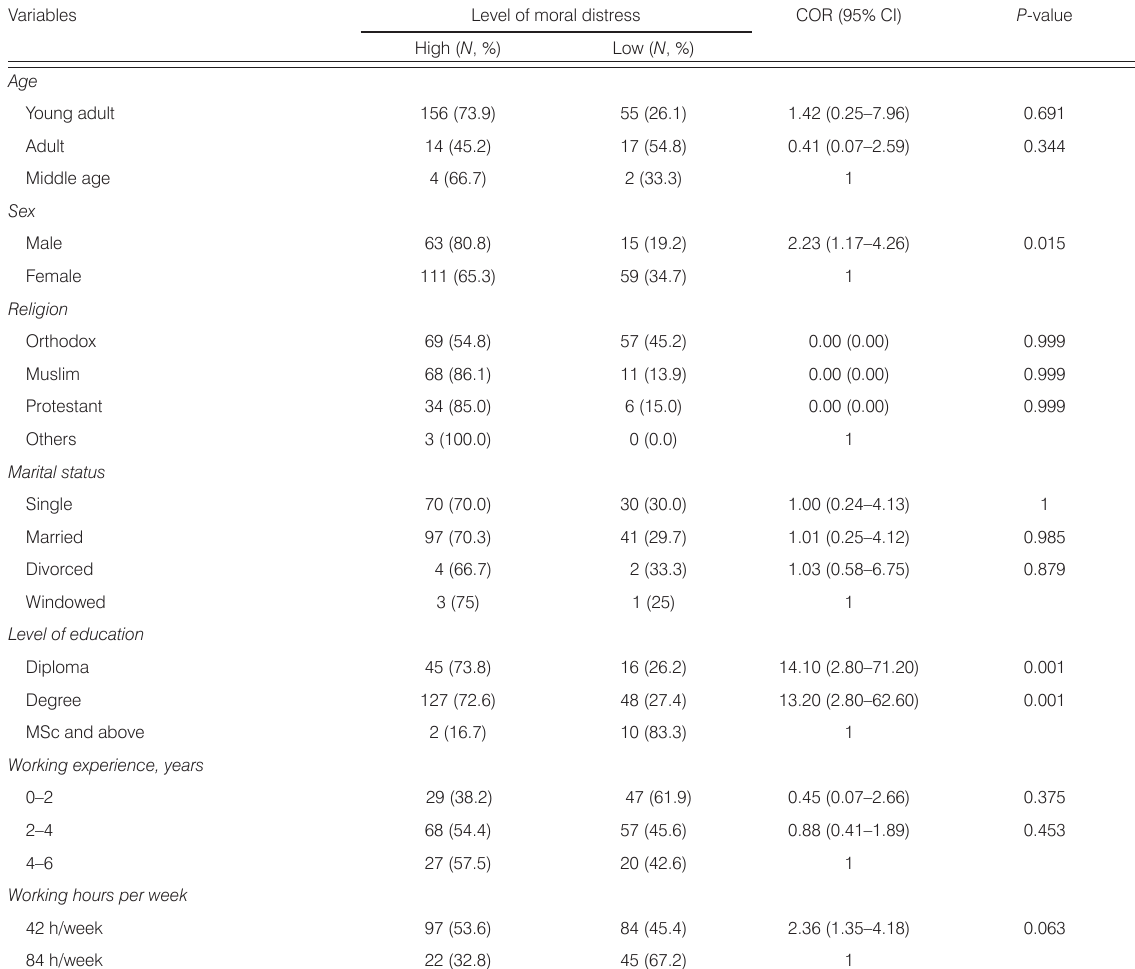
Variables Level of moral